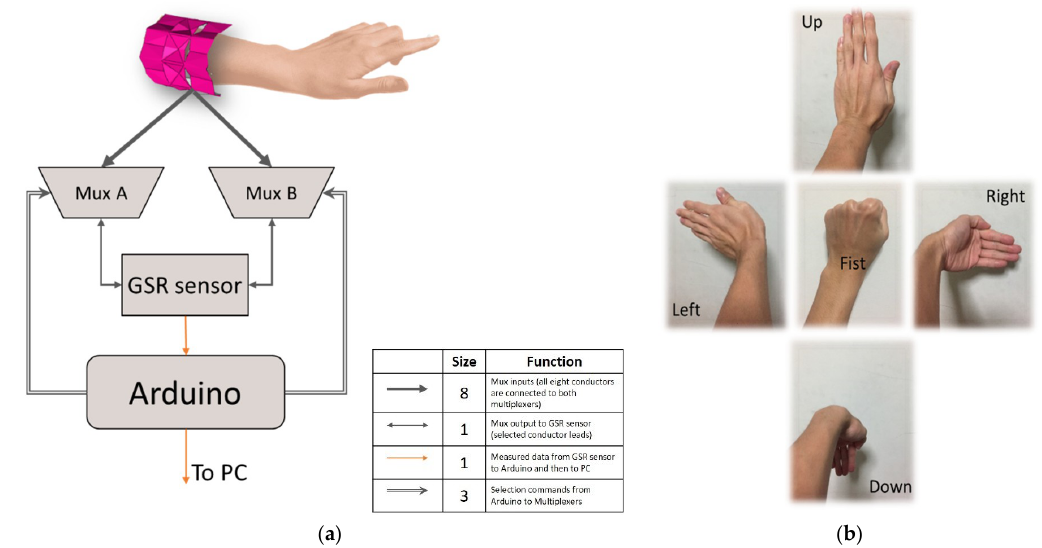
Figure 3. ( a ) Overall data acquisition system. The legend table for the different data and